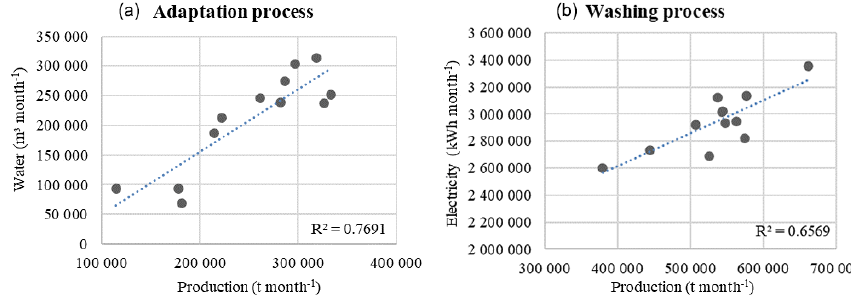
Figure 4. Water and energy footprints in MEA based on the BAU database. Table 6. Water and energy use as well as CO 2 emission by scenario of phosphate production and